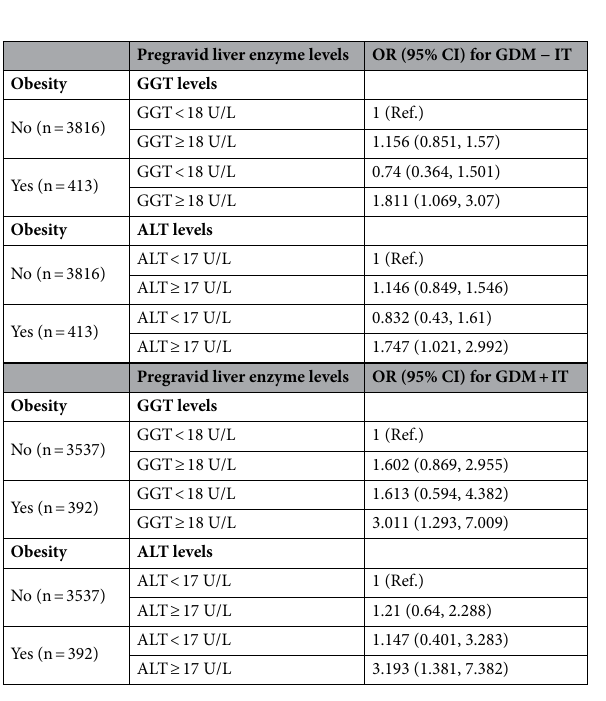
Table 3. GDM risks in a subsequent twin pregnancy, according to pregravid liver enzyme levels and obesity. Adjusted for maternal age, parity, smoking, alcohol consumption, income level, exercise status, and metabolic syndrome. ALT alanine aminotransferase, GDM gestational diabetes mellitus, GGT gamma- glutamyltransferase, OR odds ratio, CI Confidence interval. Non-GDM pregnant women without GDM, GDM − IT GDM pregnant women without insulin treatment, GDM + IT GDM pregnant women with insulin